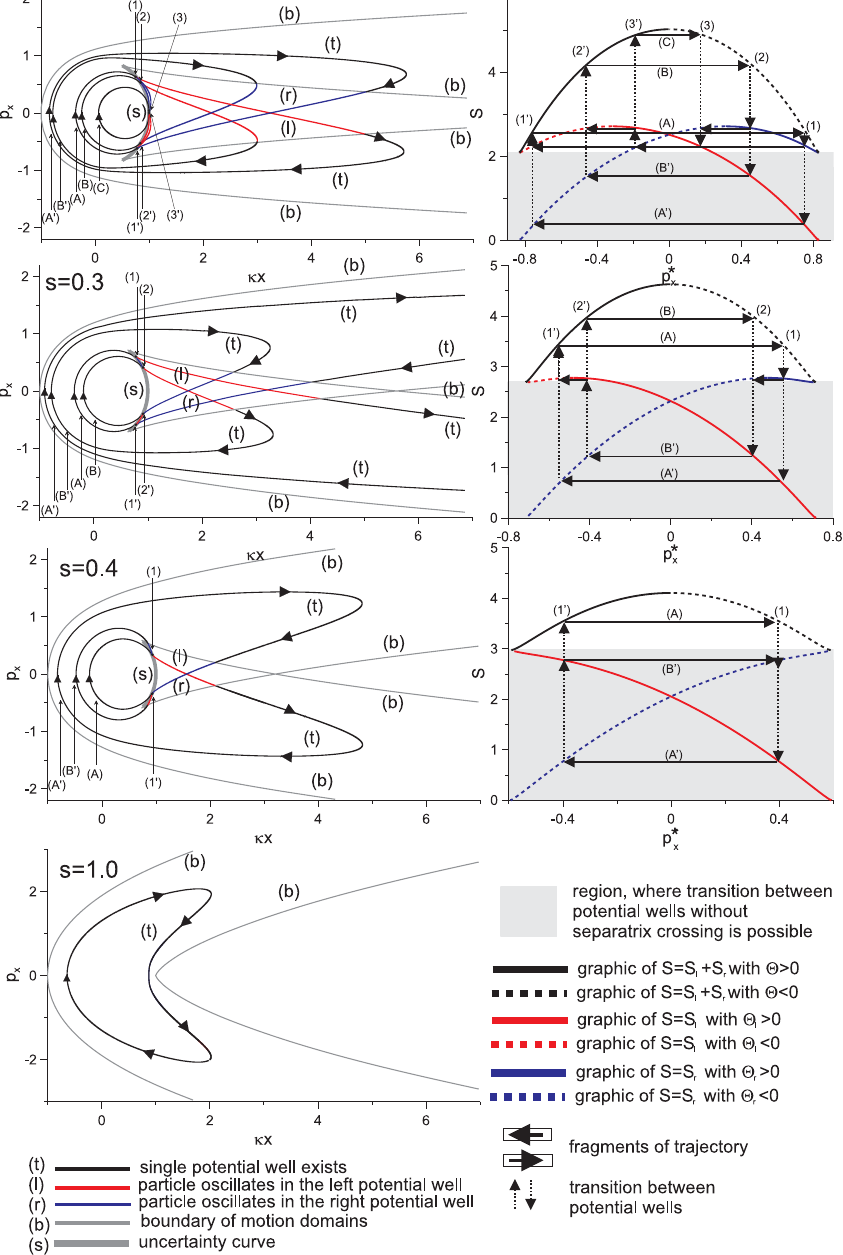
Fig. 5. Particle trajectories in the phase plane of the slow variables are shown for four values of the parameter s (the left column). Corre- sponding profiles of S l , r and S are shown in the right